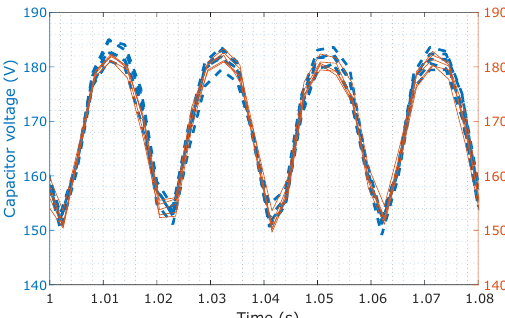
Figure 15. Comparison of the arm capacitor voltages when the modulation uses a sorted list based on measurements without delay (dashed blue line) and with delays of two samples (continuous orange